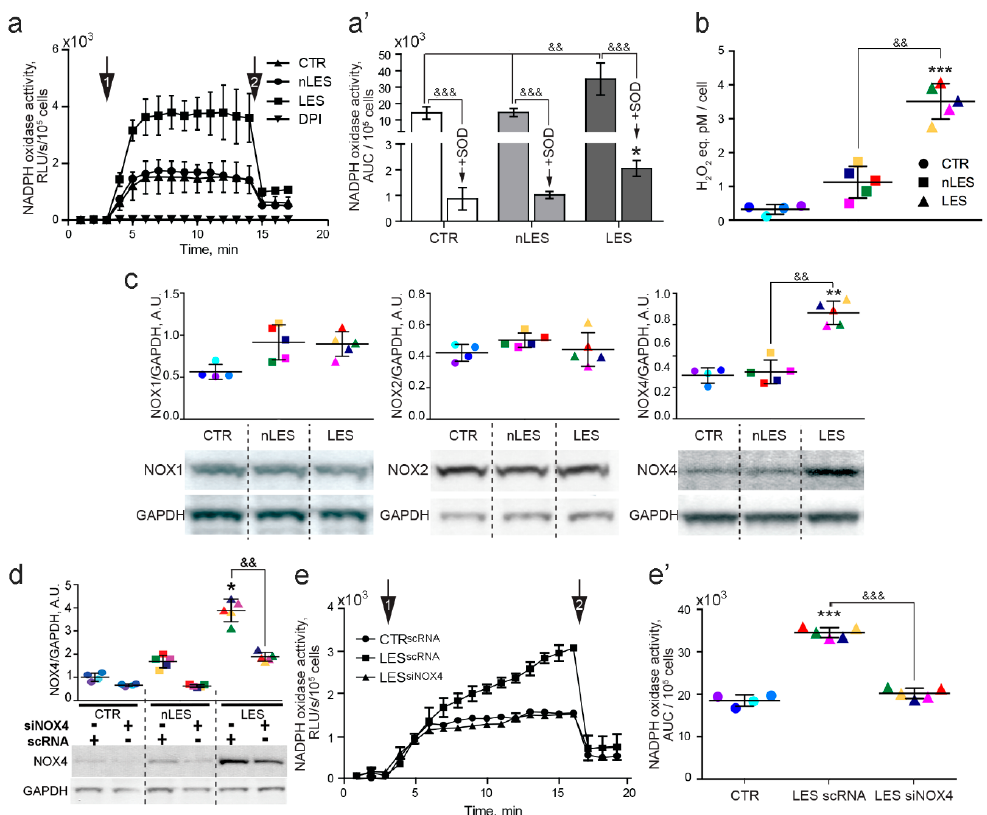
Figure 4. NADPH oxidase activity, expression and intracellular localization in human